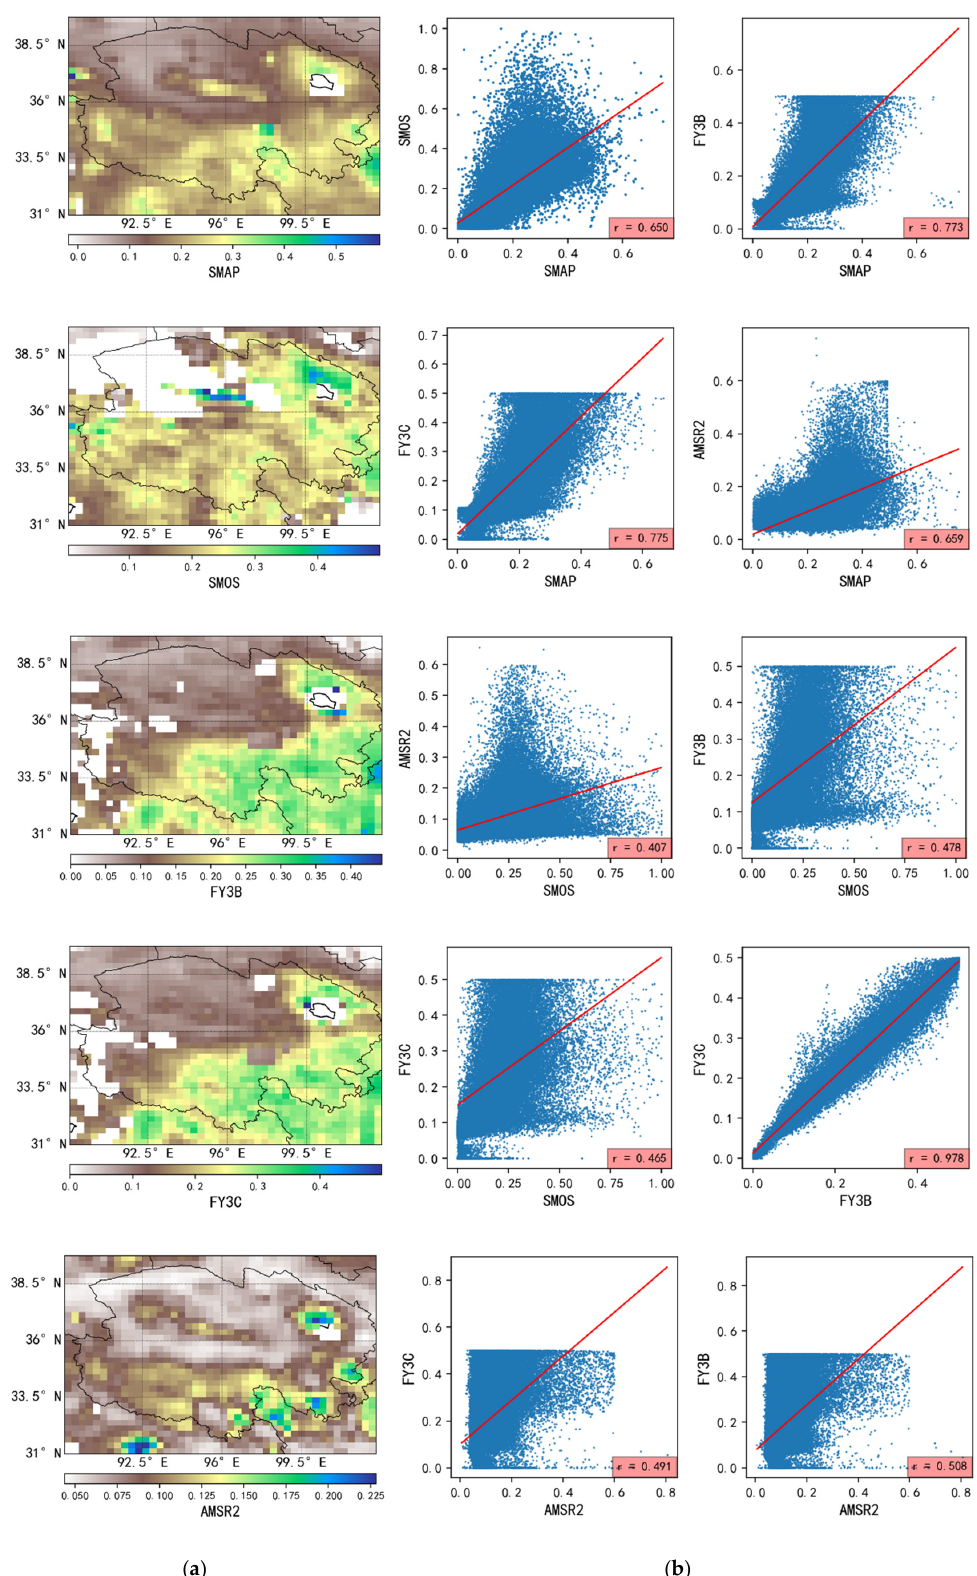
Figure 2. The picture of passive satellite products: ( a ) The average daily soil moisture in the study area from various passive satellite products (leftmost column); ( b ) Scatterplots showing the correlation between these products (two rightmost